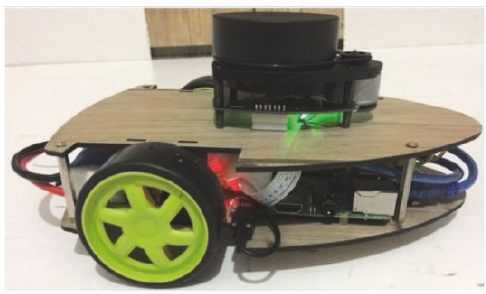
Figure 2: Robot used for implementation and test. Equipped with a RPLIDAR A1